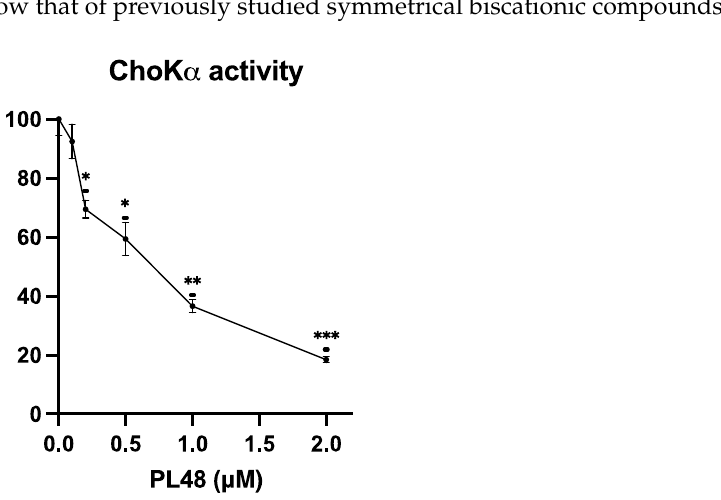
Figure 5. Effects of PL48 on choline kinase (ChoK) α 1 activity. ChoK α 1 activity was determined by the incorporation rate of 14 C from [methyl- 14 C]choline into phosphocholine (PCho) in the absence or presence of different PL48 concentrations. The results are expressed as the percentage of enzymatic activity compared with the control. * p < 0.05, ** p < 0.001, *** p < 0.0001.